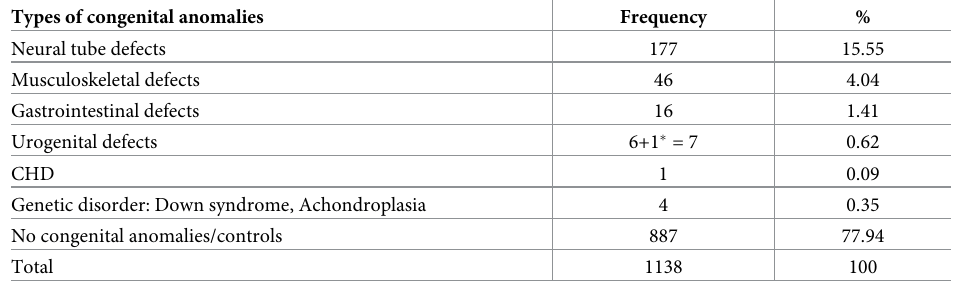
Table 1. Frequency of congenital anomalies by organ/organ system among study subjects in southwestern